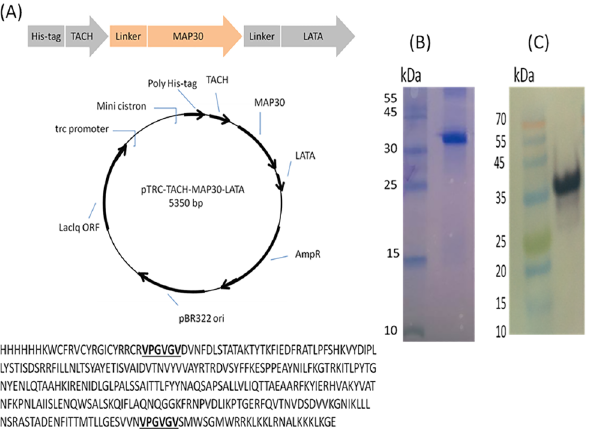
Fig 1. Design and production of the recombinant peptide-fusion protein. A) The short peptides TACH and LATA were fused to MAP30 as a central protein using a six amino-acid linker. The TACH-MAP30-LATA expression cassette including 6XHis tag at the N-terminal of fusion protein was cloned into the appropriate E . coli expression vector and transformed into E . coli BL21. B) SDS-PAGE was done to determine the molecular weight of the purified peptide-fusion protein (~37 kDa). C) Immunoblotting using anti-6XHis tag